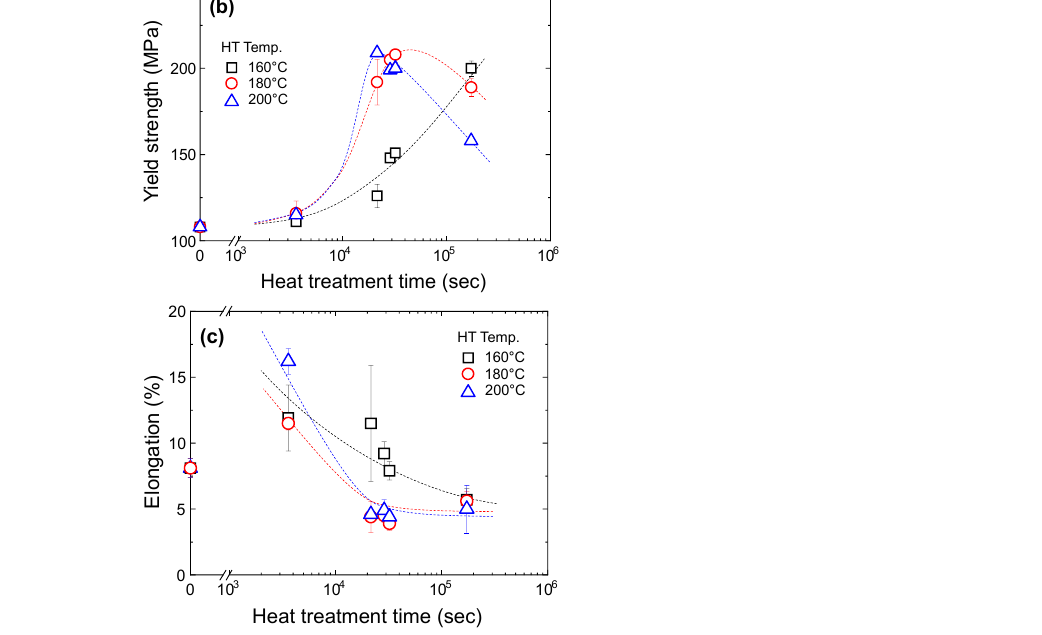
Figure 2. The effect of T5 heat treatment conditions on ( a ) tensile strength, ( b ) yield strength, and ( c ) elongation of CPC A356 specimens.